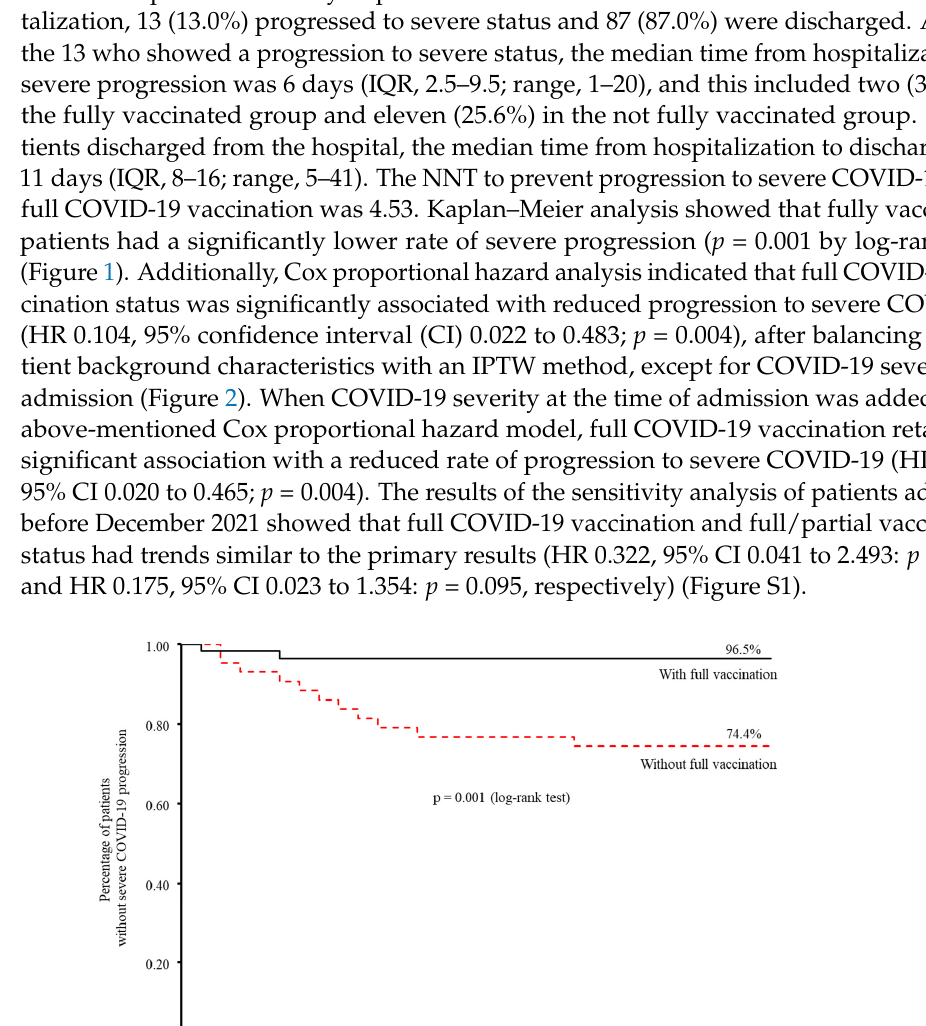
Figure 2. Absolute standardized differences in patients with and without full vaccination before and after IPTW. Abbreviations: IPTW, inverse probability of treatment weight; ACE, angiotensin-con- verting enzyme; ARB, angiotensin II receptor blocker; BMI, body mass index; COVID-19, corona- virus disease 2019.